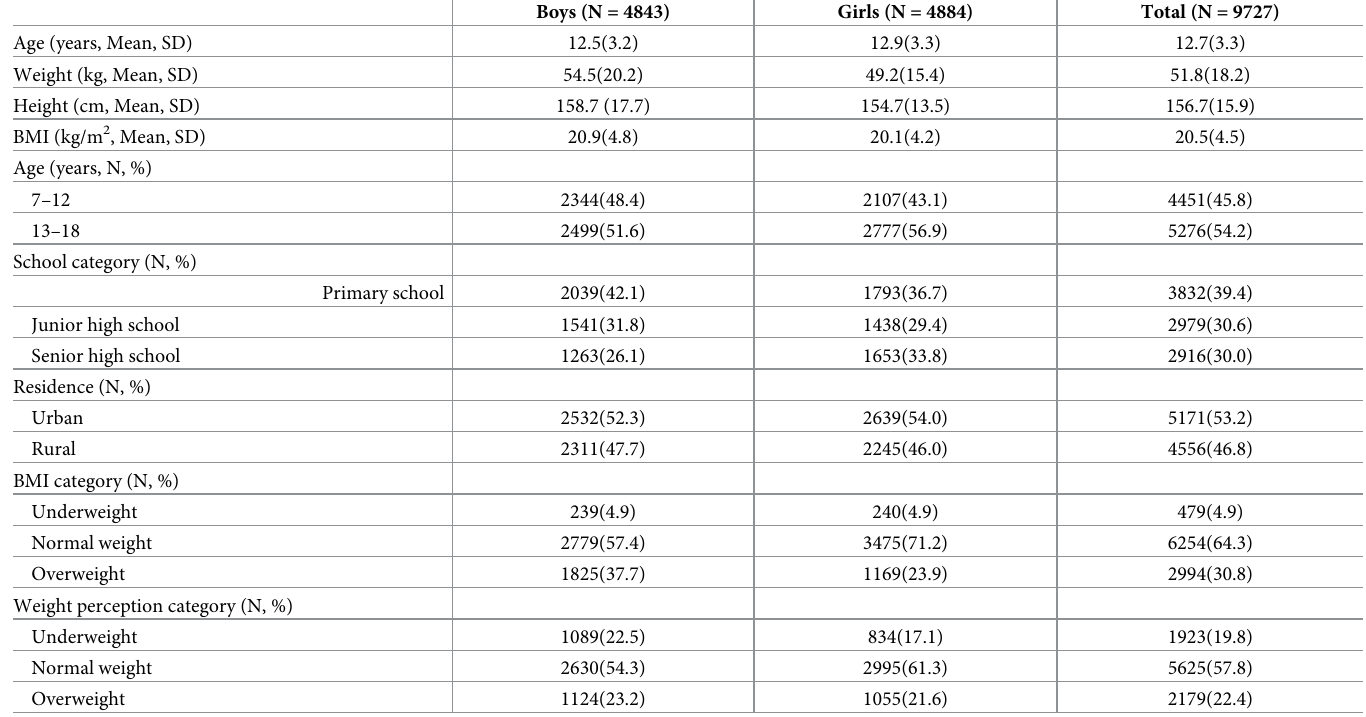
Table 1. Descriptive characteristics of the